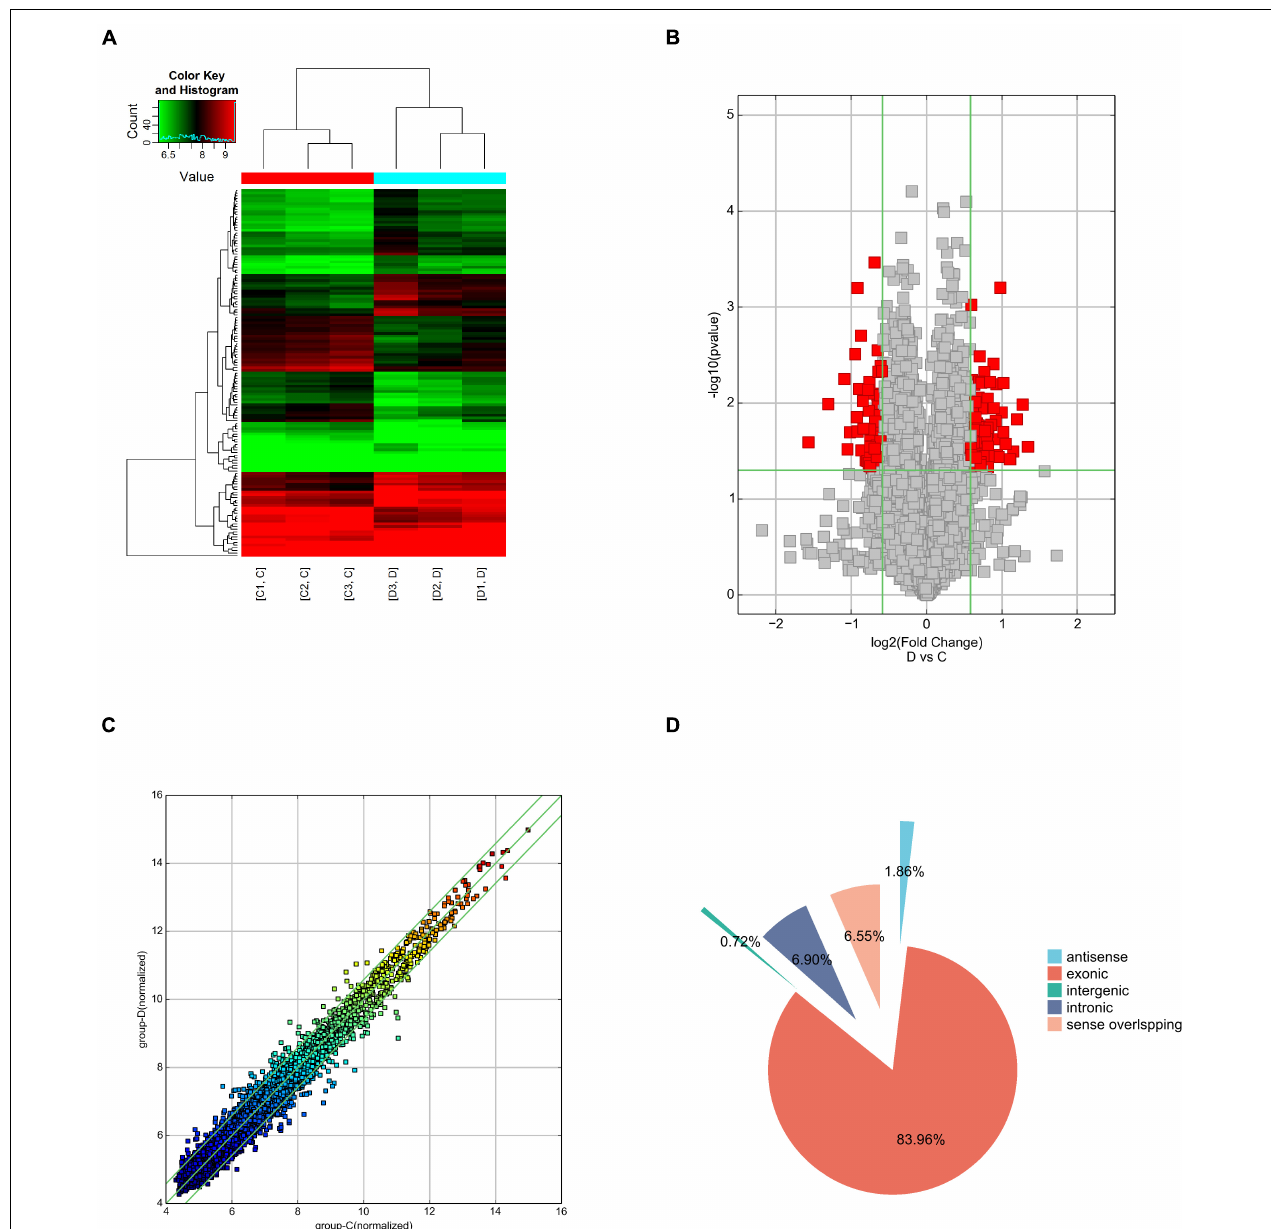
FIGURE 1 | Overview of the circular RNA (circRNA) microarray expression data. (A) Hierarchical clustering of the differentially expressed circRNA expression data in the PD group and control group, and upregulated and downregulated circRNAs are colored in red and green, respectively. (B) Volcano plot of the differentially expressed circRNAs in the PD group and control group. The vertical green lines indicate a 2.0-fold (log2-scaled) up and down, respectively. The horizontal green line represents P = 0.05 (–log10-scaled). The red squares in the plot represent the differentially expressed circRNAs with statistical significance. (C) The scatter plot reveals the variation in circRNA expression between the PD group and control group. The X and Y values on the scatter plot are the average normalized signal values, shown on a log2 scale. The green fold-change lines represent 2-fold changes, thus circRNAs above or below the green lines indicate > 2.0-fold upregulation or downregulation. (D) Classification of circRNAs in the PD group and control